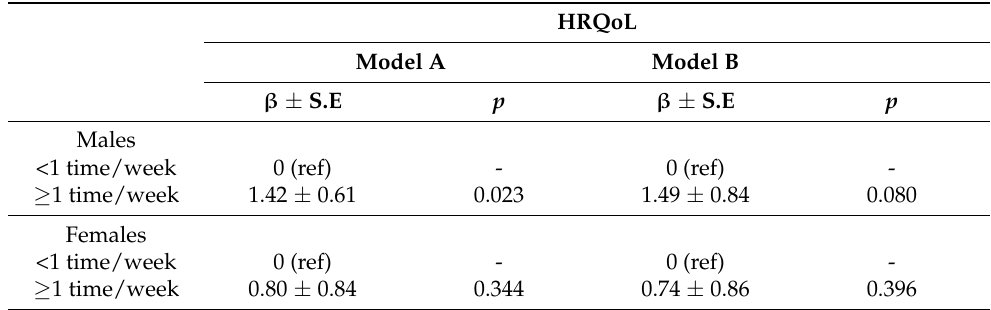
Table 4. Adjusted linear regression and 95% confidence interval (95%CI) of HRQoL by night eating frequency.